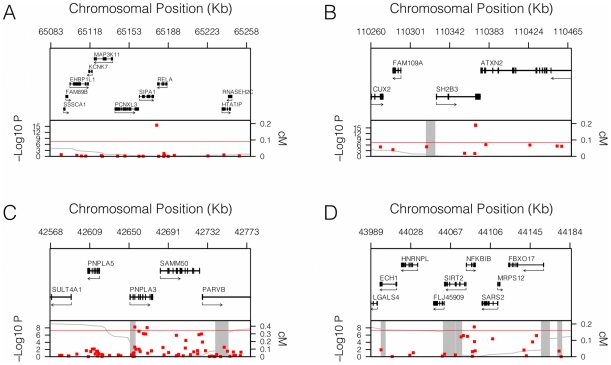
Genomic context of novel associations.Genomic context for each of the four novel loci with significant association with sICAM-1 concentration. (A) RELA locus (11q13.1); (B) SH2B3 locus (12q24.12); (C) PNPLA3 locus (22q13.31); and (D) NFKBIB locus (19q13.2). Upper panel: Genes from RefSeq release 25. Only one isoform is shown when multiple splicing variants are known. Lower Panel: SNPs are shown according to their physical location and –log10 P-values for association with sICAM-1 (red dots). The red line represents the genome-wide significance threshold of 5×10−8. Also shown is the genetic distance in cM from the lowest P-value SNP (light grey line) along with the position of recombination hotspots (light grey vertical bars). Recombination rates and hotspots are based on HapMap data, as described by McVean et al. [43] and Winckler et al. [44].